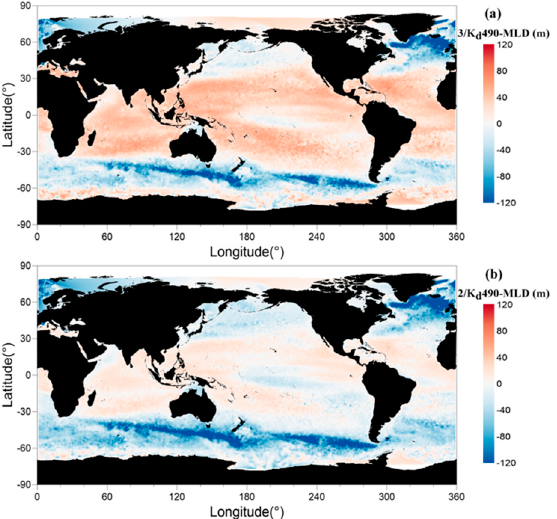
Figure 7. Comparison of detection performance at different detection abilities of a lidar system under 3 AL ( a ) and 2 AL ( b ).